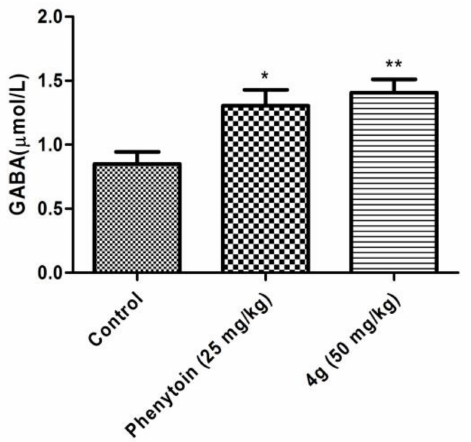
Figure 3. Effect of 4g and phenytoin on whole brain GABA concentration in mice. Data are presented as mean ± SEM. of six animals. * p < 0.05, ** p < 0.01 vs. control (animals treated with